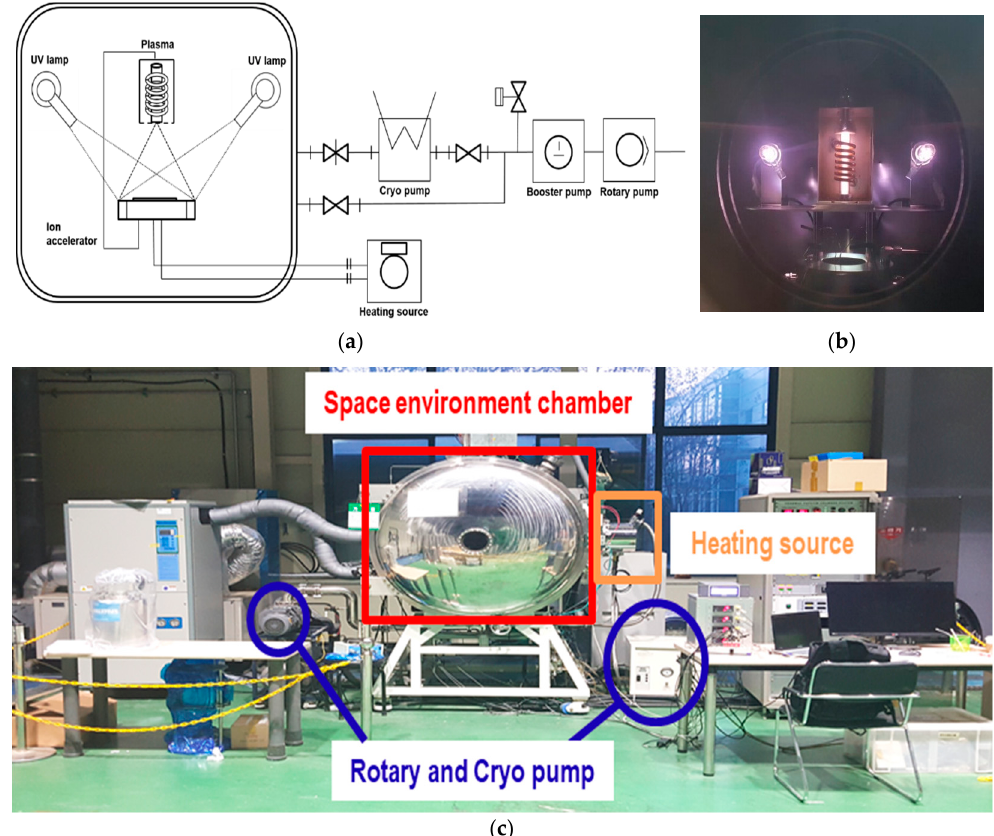
Figure 1. Space environmental chamber: ( a ) schematic diagram, ( b ) built-in chamber, and ( c ) over- all